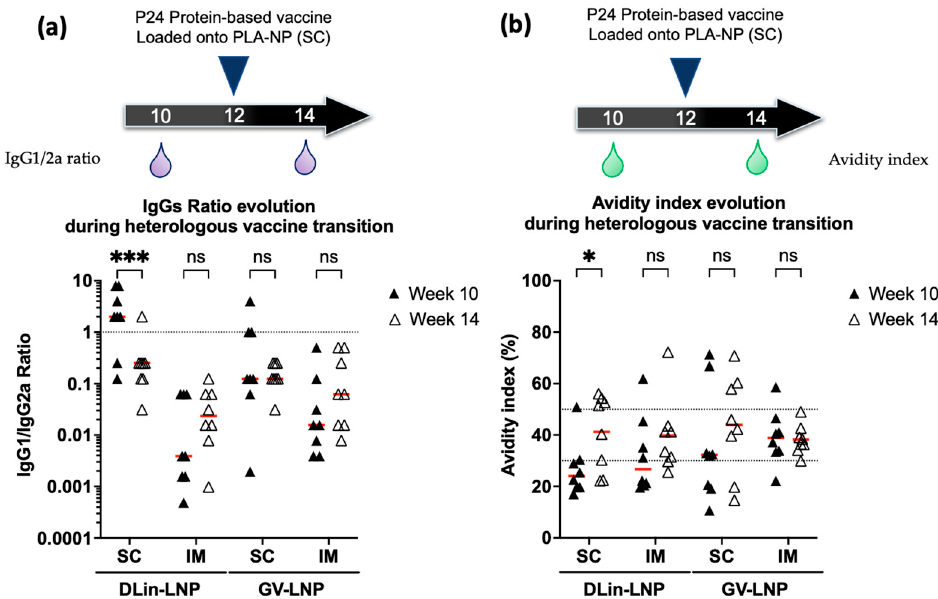
Figure 4. Protein boost in SC injected mice with DLin-LNP significantly changed immune response polarization and antibody quality. Specific IgG1/IgG2a ratios ( a ) and avidity indices ( b ) were measured before and after heterologous protein boost. The dotted line in ( a ) represents the equivalent cellular/humoral response. The dotted lines in ( b ) underline the 30% and 50% avidity index borders. Below 30%, antibodies are considered to have weak avidity, whereas values above 50% indicate strong avidity, and those between denote intermediate avidity. The red lines represent the means of each group. The Mann–Whitney U nonparametric test was used to reveal significant differences ( p > 0.05: NS, p < 0.05 *, and p < 0.001 ***).